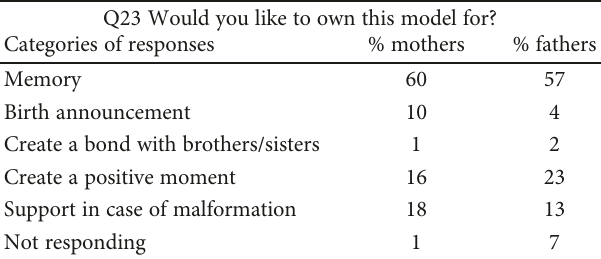
Table 5: Answers to Q23: would you like to own this model for? Q23 Would you like to own this model